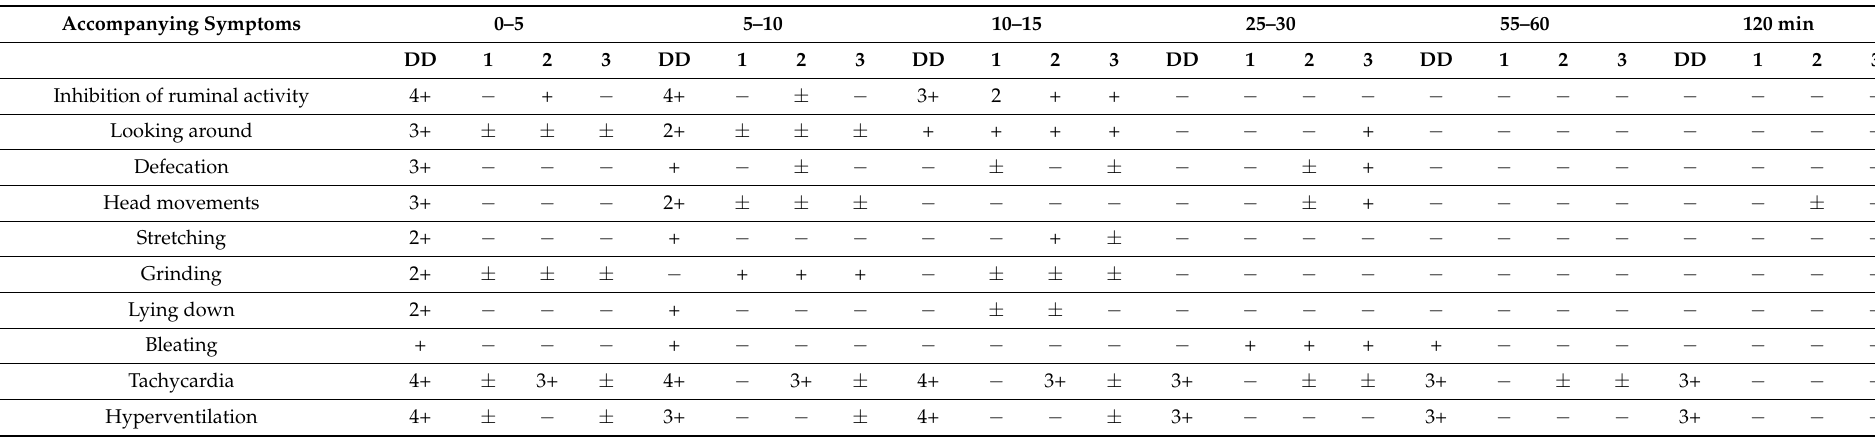
Table 4. The effect of duodenal distension by 40 mL of water (DD40) on the ruminal motility (inhibition in %/5 min in comparison to control values) and behavioral symptoms (number/5 min) in sheep before and after voltage-gated calcium channel inhibitor (diltiazem—1, nifedipine—2 and verapamil—3) pretreatment at a dose of 1 or 2 mg in toto (i.e., 25 or 50 µ g · kg − 1 body weight (b.w.); n =